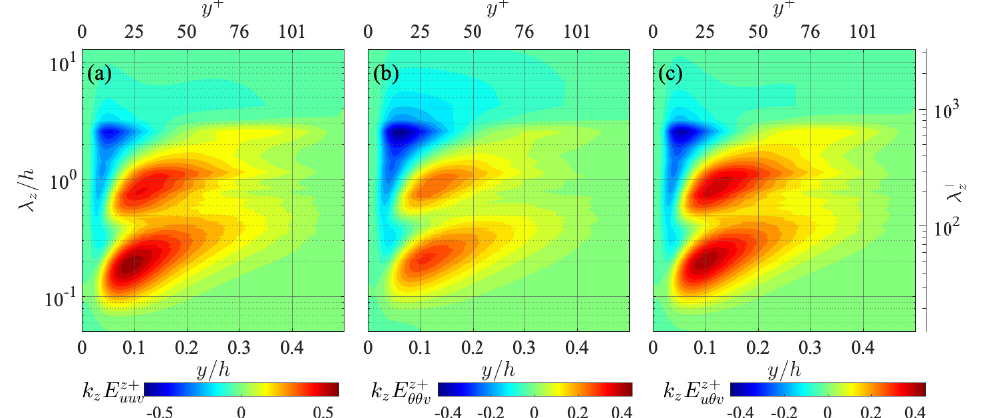
Figure 8. Spanwise one-dimensional premultiplied spectra of turbulent spatial fluxes of ( a ) stream- wise turbulent energy k z E z uuv , ( b ) temperature fluctuation k z E z relation k z E z , presented in the same manner as in Figure 3. The values are scaled by u 3 τ , u τ T 2 τ , u θ v and u 2 τ T τ , respectively.